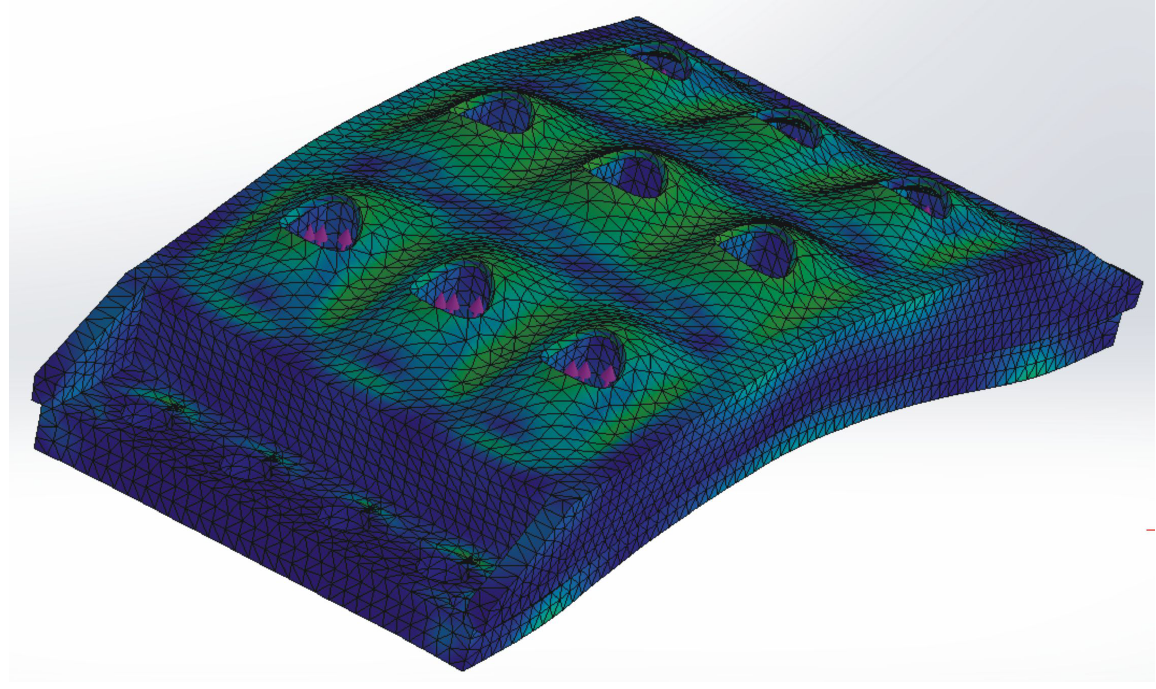
Figure 23: FEM simulation of the retention cage of the magnets.